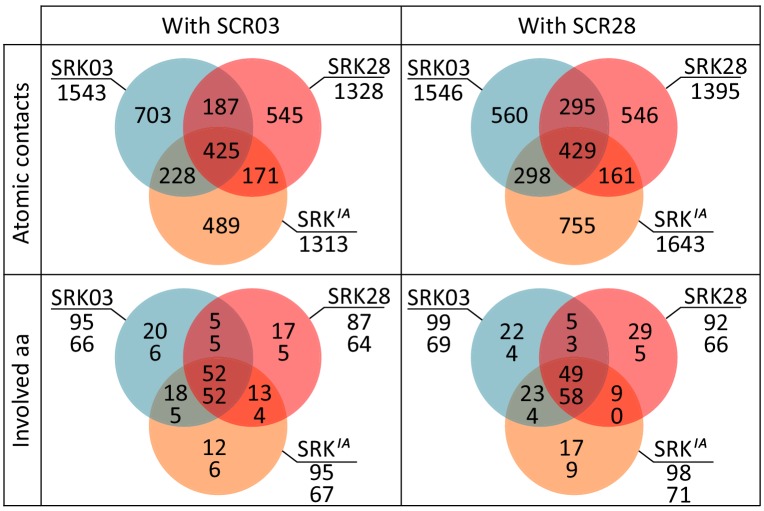
Venn diagram representations of binding features for SRK03, SRK28 and SRKaIA receptors coupled with either SCR03 or SCR28 ligand.Two features were compared: (i) Atomic contacts are defined by the nature of the amino acid in both proteins, the chain they belong to, their position and the respective atoms involved in the contact (C, N, O, CA main chain atoms or the side chain atoms Cα, Cβ, Cε, …) and (ii) The amino acid involved are defined by the nature of the amino acid, the chain they belong to and their position, independently for SRK (numbers on top) and SCR (bottom numbers). For instance, SRKaIA shared 228 atomic contacts with SRK03 and only 171 contacts with SRK28, when complexed with SCR03. This tendency is also apparent when SRKaIA was complexed with SCR28 (298 identical contact with SRK03 but only 161 with SCR28).